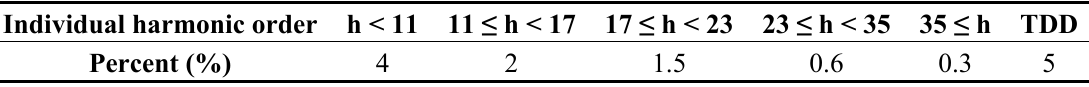
Table 6. Main parameters for the PV system used in the